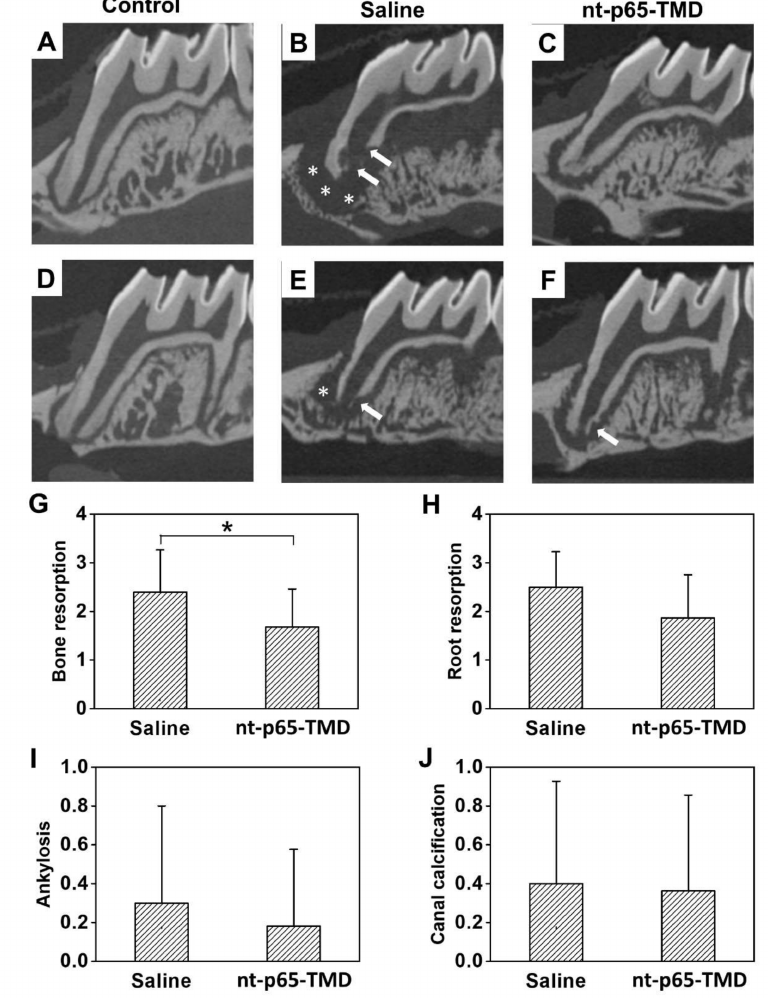
Figure 3. Two-dimensional horizontal microcomputed tomography images of rat maxillary first molars 4 weeks after replantation. ( A , D ) Control: The teeth without extraction and replantation. Both bone and root resorption was not observed. ( B , E ) Saline group: 0.9% physiological saline was applied to the extracted teeth surface and alveolar socket. Severe, extensive bone (white asterisk) and root resorption (arrow) were observed. ( C , F ) nt-p65-TMD group: 10 µ M p65-TMD solution was applied to the surface of the extracted teeth and alveolar socket. A relatively short range of bone resorption (white asterisk) was observed compared to that in the saline group. ( G – J ) Evaluated scores, represented as mean ± standard deviation, for ( G ) bone resorption, ( H ) root resorption, ( I ) ankylosis, and ( J ) pulp mineralization in the saline and nt-p65-TMD groups. Based on the scores of the four categories, only bone resorption showed a significant decrease in the nt-p65-TMD group; Mann–Whitney U test, * p <